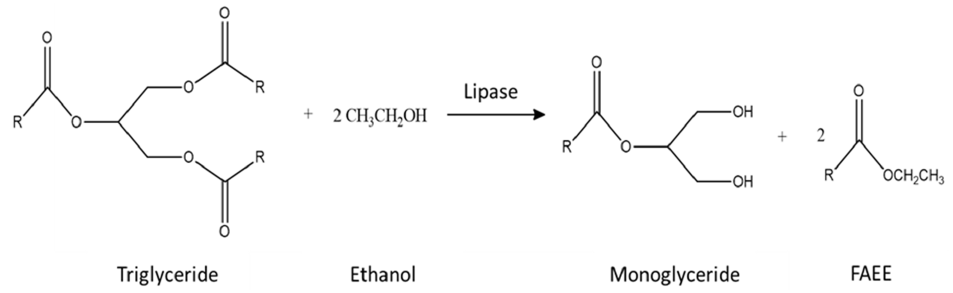
Figure 1. Reaction scheme of the 1,3-selective enzymatic catalysis to produce Ecodiesel, a biodiesel- Reaction scheme of the 1,3-selective enzymatic catalysis to produce like biofuel.